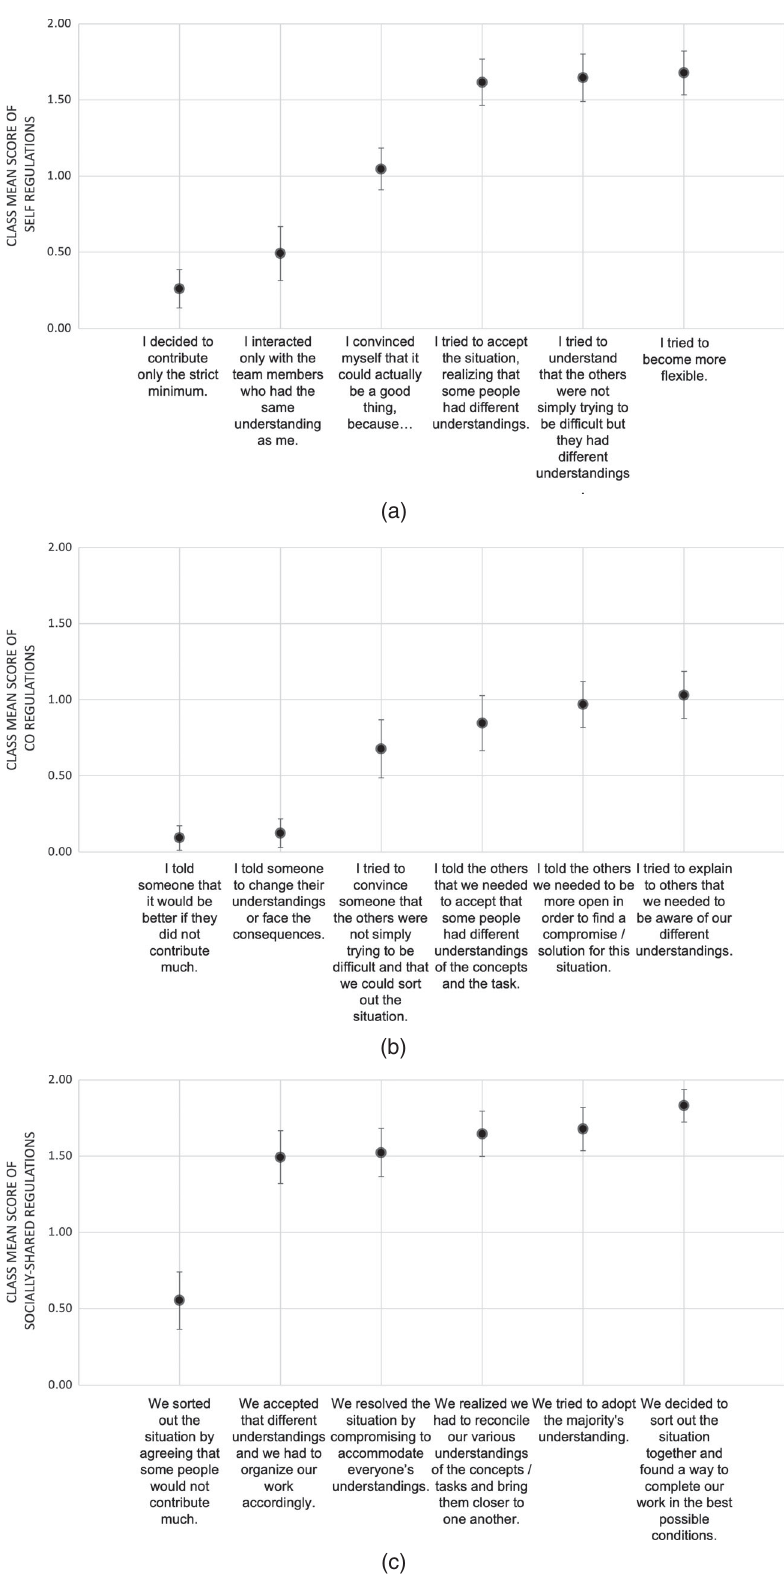
FIG. 5. Students were asked to rank the frequency that they used each of the (a) self-regulations, (b) co-regulations, or (c) socially shared regulations to overcome the challenge of having differing understandings of concepts where 2 is always or often, 1 is sometimes or rarely, and 0 is never. The uncertainty is given by the standard error of the